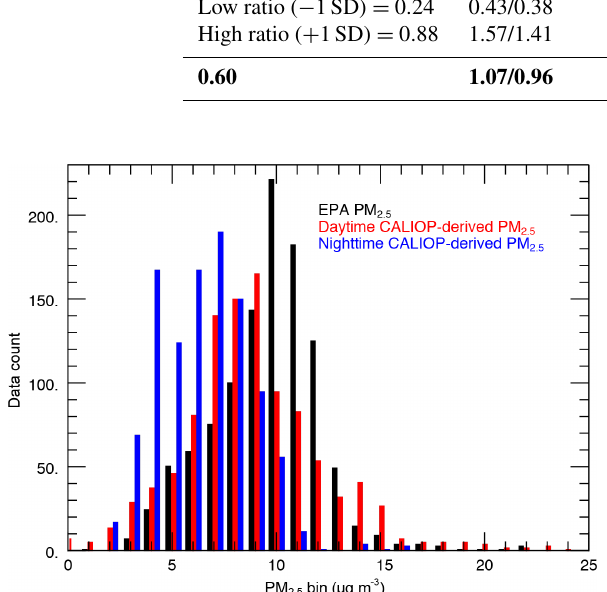
Figure 6. The 2-year (2008–2009) histograms of mean PM 2 . 5 con- centrations from the U.S. EPA (in black) and those derived from aerosol extinction using nighttime (in blue) and daytime (in red) CALIOP data. The U.S. EPA data shown are not collocated, while those derived using CALIOP are spatially (but not temporally) col- located, with EPA station